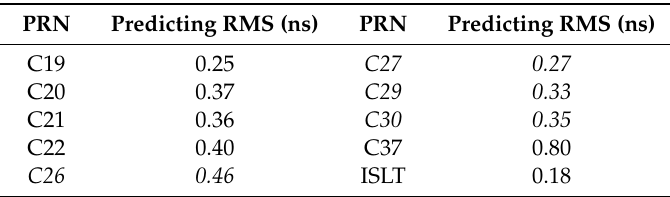
Table 4. Short-term clock prediction accuracy.